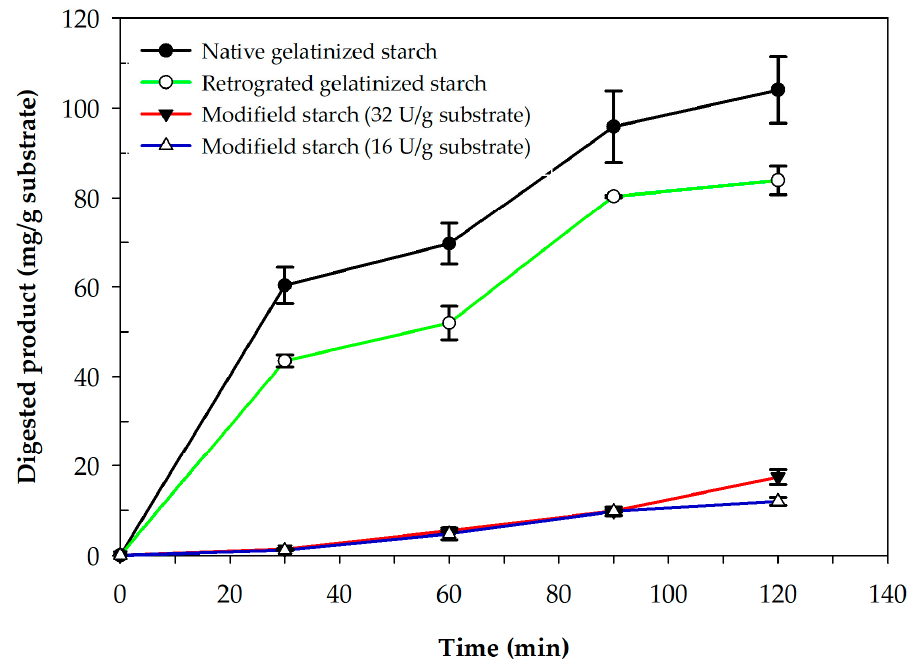
Figure 8. In vitro digestibility of HL12Pul-treated modified starch and native starch using α -amylase Figure 8 from porcine pancreas in 20 mM sodium phosphate buffer saline pH 7.0 at 37 ◦ C for 30–120